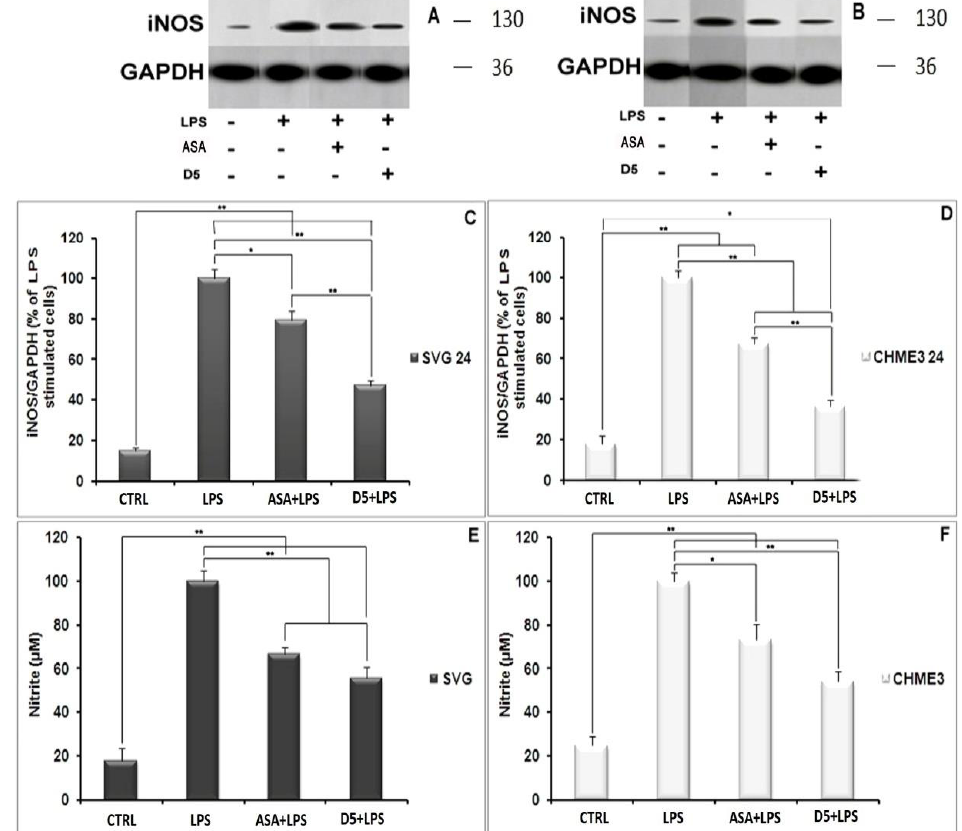
Figure 2. Regulatory impact of D5 on iNOS expression and NO secretion from LPS-stimulated SVG astrocyte and CHME3 microglia cell lines compared to ASA, positive and negative control groups: ( A , B ) Figures show the representative images from Western blotting analysis representing the optimum bands of protein assay extracted from SVG ( A ) and CHME3 ( B ); ( C , D ) the astrocytic glial (SVG)( C ) and microglial (CHME3)( D ) cells were treated with D5 (0.71 µM) and ASA (52.73 µM) for 2 h, and then treated cells were incubated with LPS (100ng/mL) for 24 h. Thereafter, the total cellular proteins were extracted, and the level of iNOS expression induced by LPS was measured using Western blot analysis. Optical densities of individual bands were quantified using ImageJ software and the obtained data were normalized to the corresponding levels of GAPDH; ( E , F ) SVG astrocytic glial and CHME3 microglial cells were treated with D5 (0.71 µM) and ASA (52.73 µM) for 2 h and then incubated with LPS (100ng/mL) for 24 h. the level of NO secretion (µM) extracted from SVG and CHME3 cells induced by LPS was measured in a culture medium at different concentrations using nitrite assay. The efficacy of D5 on down-regulation of the NO secretion was compared to those of ASA, negative and positive control groups. Data were presented as the mean ± SD of four samples in one independent experiment. The data were replicated in three repeated independent experiments. * p < 0.05; ** p < 0.01 probability.